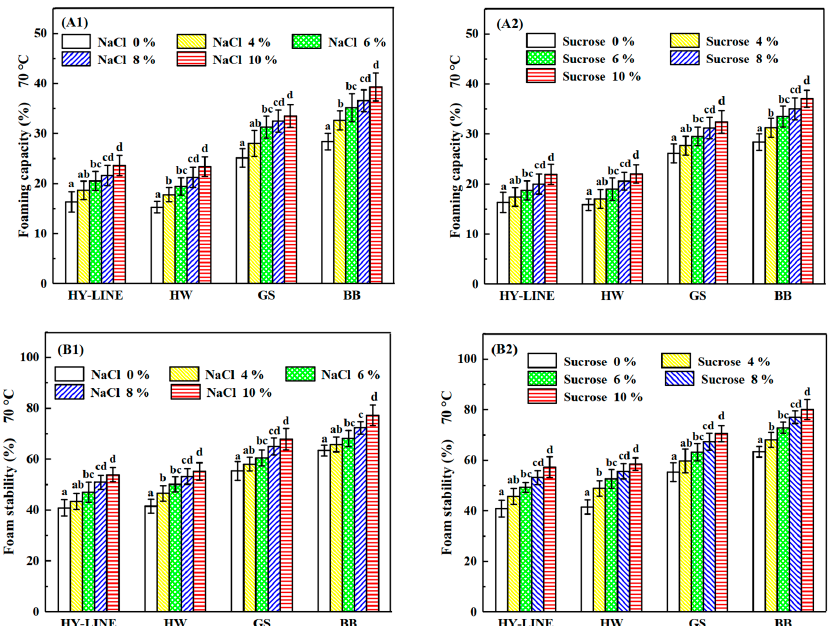
Figure 3. Foaming capacity and foam stability of four varieties of EWP after heat treatment. ( A1 ) Foaming capacity of four varieties with different NaCl concentrations after heat treatment. ( A2 ) Foaming capacity of four varieties with different sucrose concentrations after heat treatment. ( B1 ) Foam stability of four varieties with different NaCl concentrations after heat treatment. ( B2 ) Foam stability of four varieties with different sucrose concentrations after heat treatment. Three replicate samples were measured for each treatment.